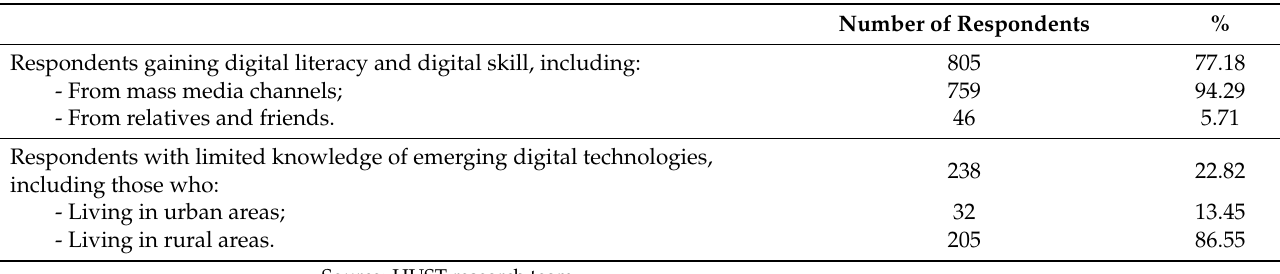
Table 6. Means of gaining digital literacy and digital skills among the respondents.